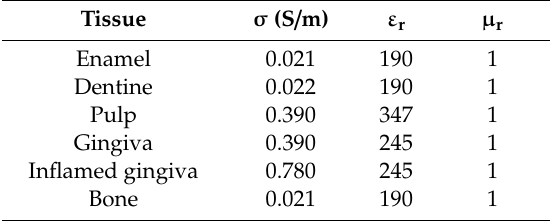
Table 1. Biological tissue electric properties at 312.5 kHz (i.e., therapeutic signal frequency).